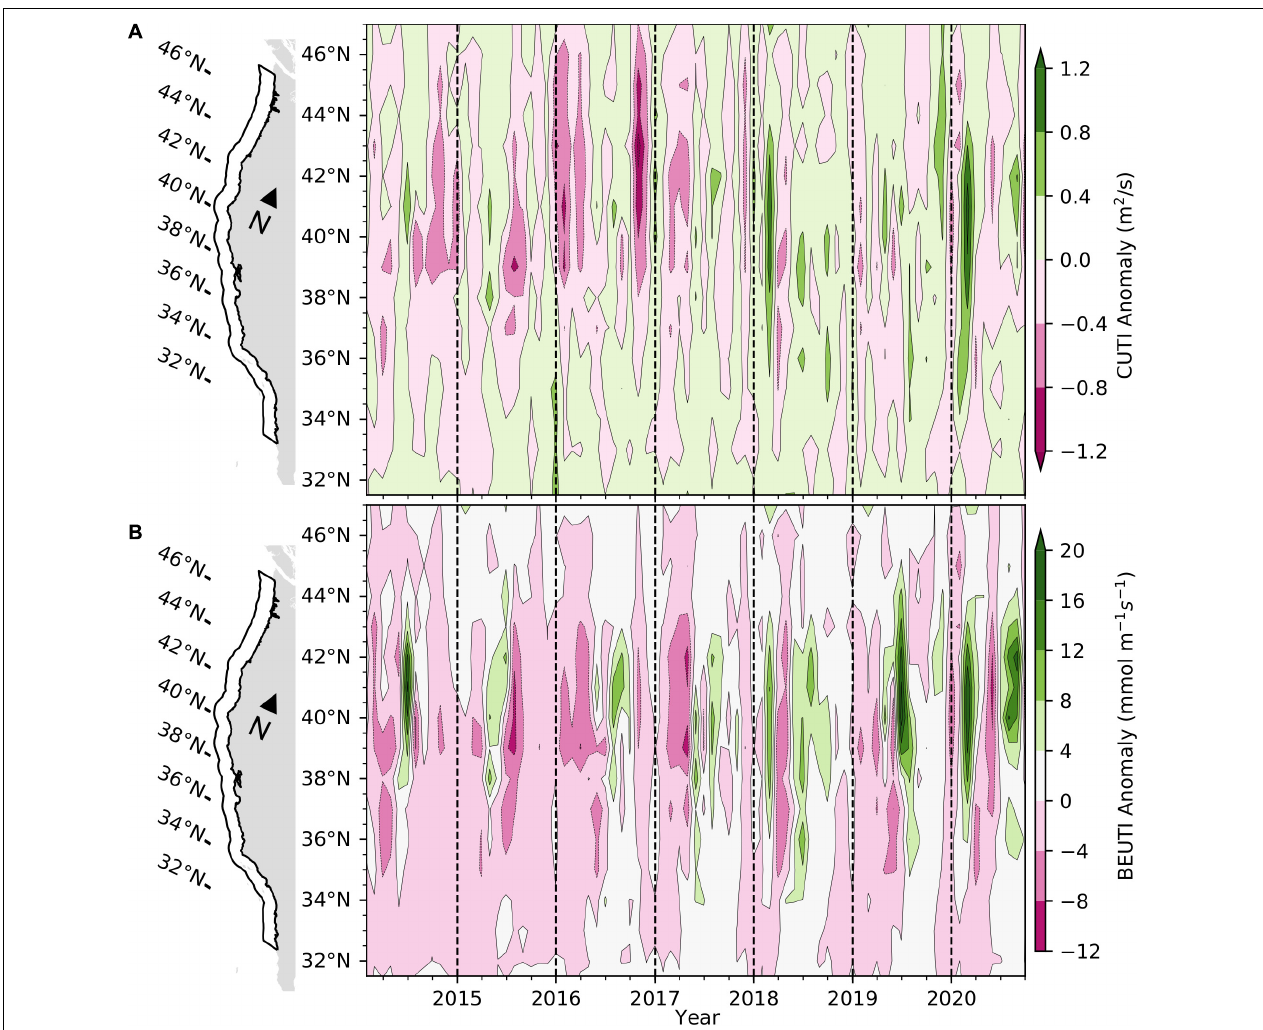
FIGURE 6 | Anomalies in the Coastal Upwelling Transport Index (CCUTI; A ) and Biologically Effective Upwelling Transport Index (BEUTI; B ) in the CCS for the period January 2014 to September 2020. Values of the BEUTI were calculated for one degree bins of latitude from the coast to 75 km offshore. Anomalies were calculated relative to 1990–2019